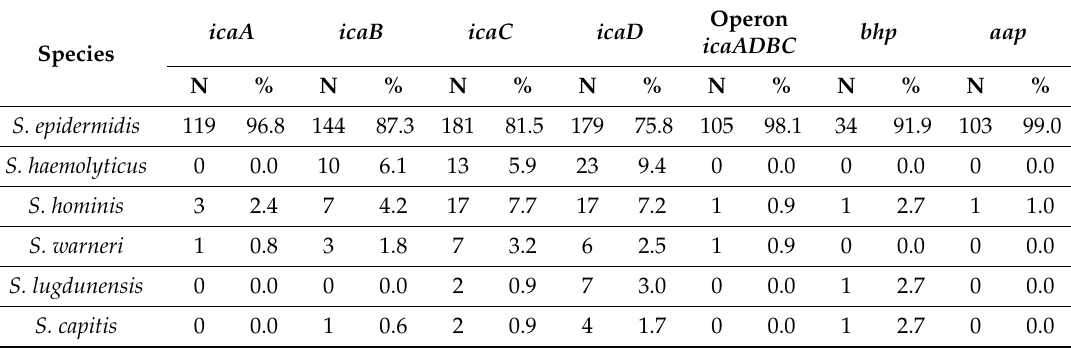
Table 1. Distribution of genes involved in the formation of Biofilm in Coagulase-negative Staphylococci (CoNS) species.